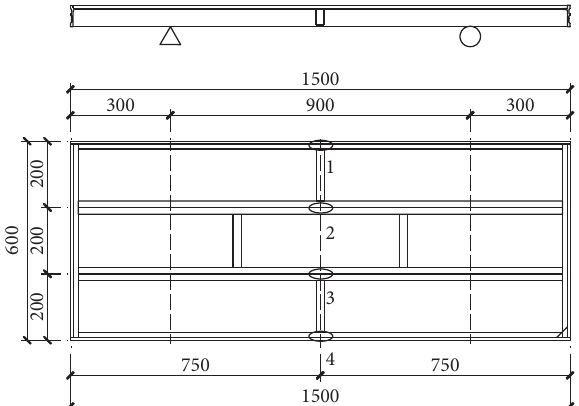
Figure 4: Arrangement of the measuring points of strain in the single-span simply supported formwork.